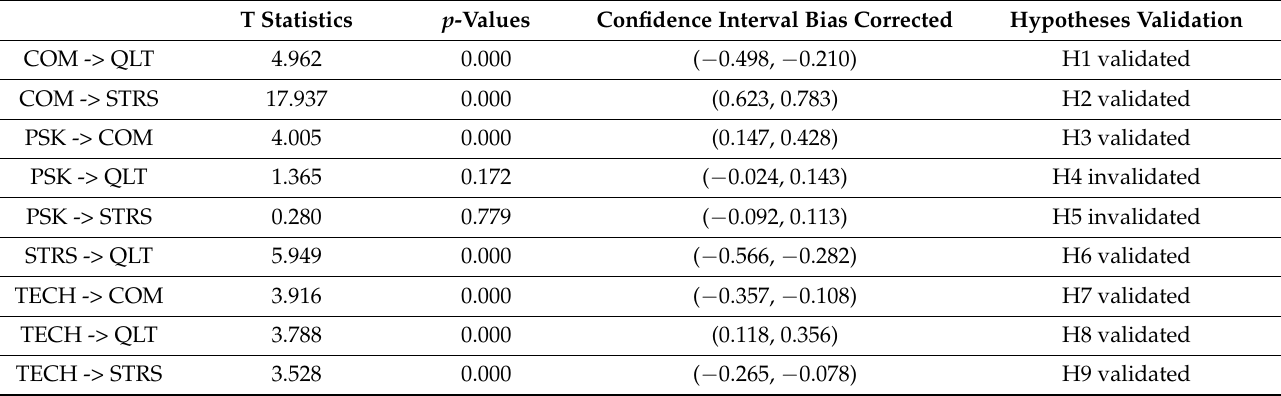
Table 7. Bootstrapping test and validation of hypotheses.